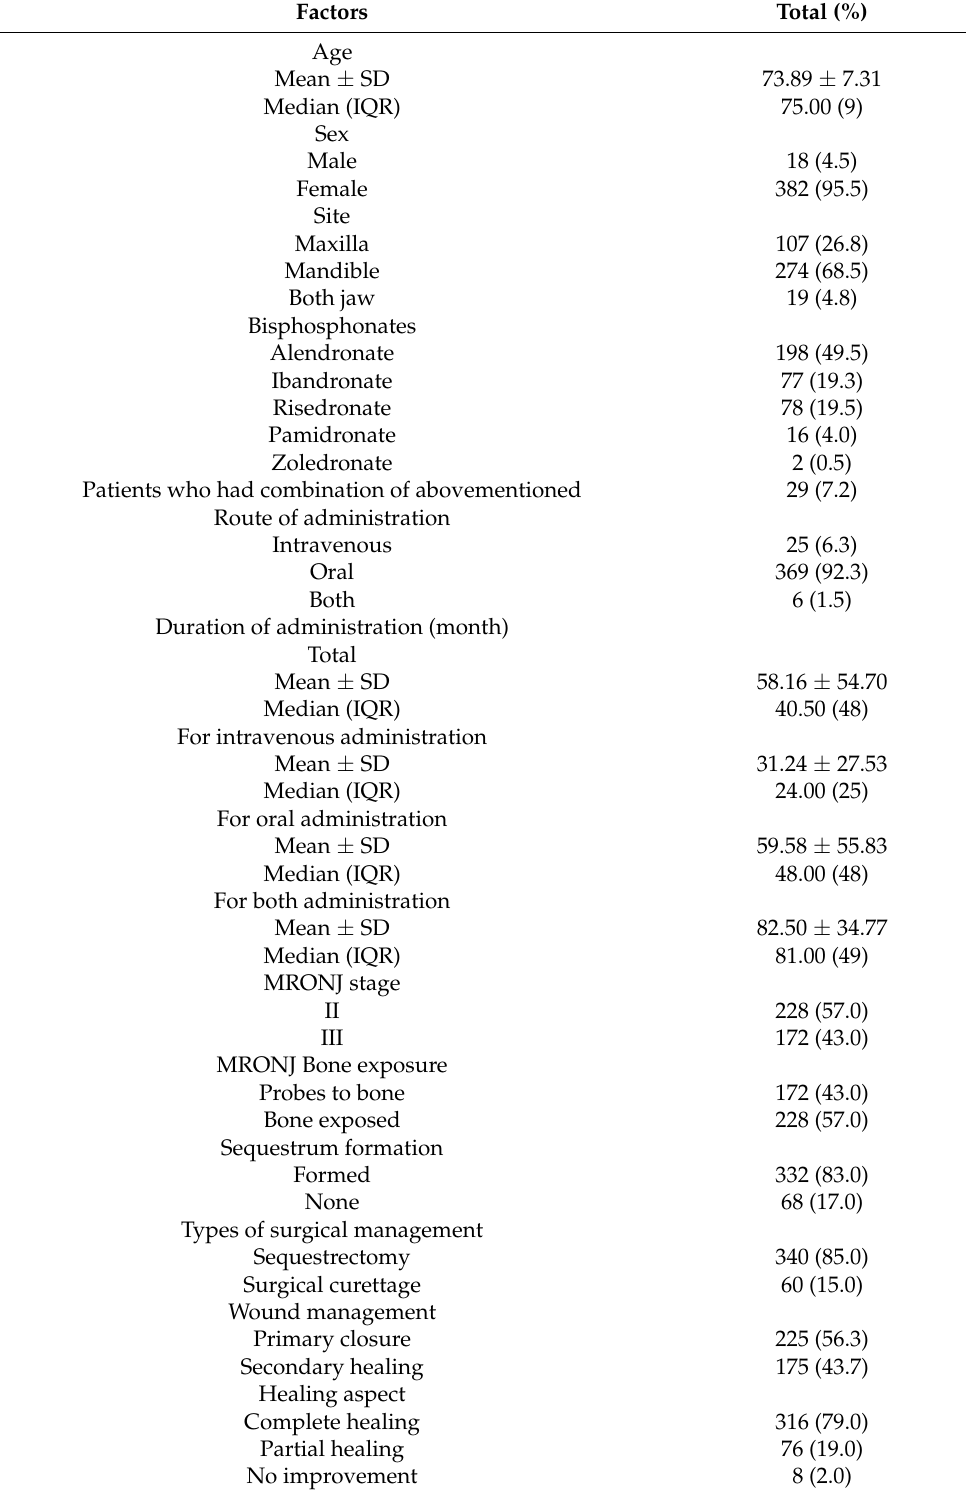
Table 1. Descriptive characteristics of the study